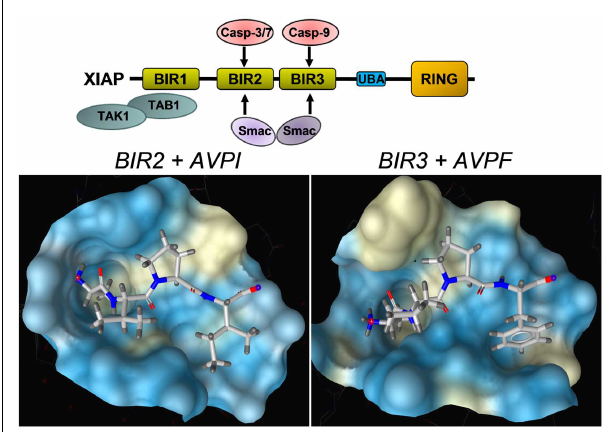
FIGURE 3 | Structural basis of the interaction between SMAC/Diablo and XIAP–BIR domains .The amino acids alanine–valine–proline at the N-terminus of SMAC/Diablo interact with the binding groove present in the XIAP–BIR2 and the XIAP–BIR3 domain, but also with binding pockets in the BIR domains of a number of other IAPs.This explains why most SMAC-mimetics designed to neutralize XIAP also target other IAPs such as cIAP1 and cIAP2. Shown are crystal structures of the binding grooves of XIAP–BIR2 in complex with the peptide AVPI [PDB number: 4J64 (12)] and XIAP–BIR3 in complex with an AVPF peptide [PDB number: 2OPZ (13)]. Surfaces of binding pockets were calculated using LigandScout (Inte:ligand GmbH,Vienna). Color encoding represents aggregated lipophilicity/hydrophobicity (hydrophobic areas in